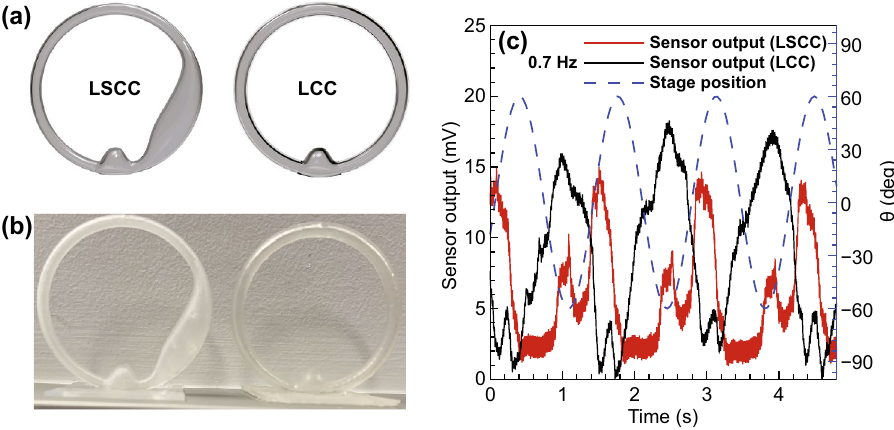
Fig. 8 a Modeling of LSCC and LCC, b 3D printed LSCC and LCC, and c sensor response to stage rotation for two cases of LSCC and